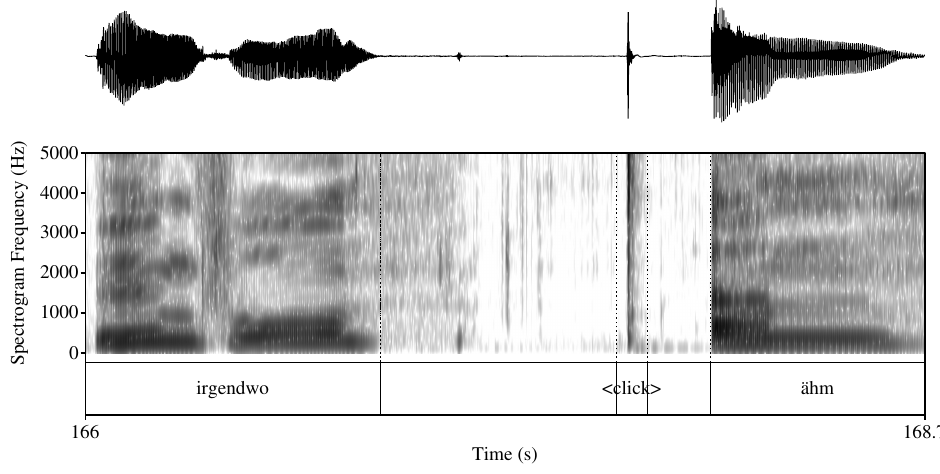
Figure 5. A click before the vocalic filler particle ähm (fv) in irgendwo <click> ähm ‘somewhere <click> um’ (source: